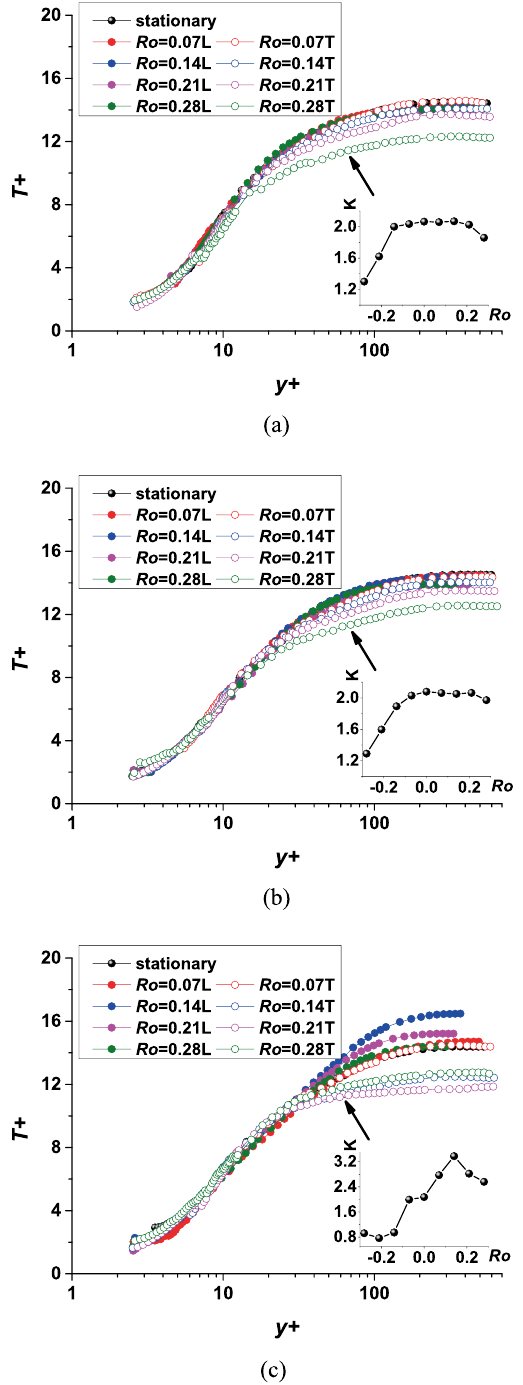
Figure 8. Dimensionless temperature profiles under different Ro and x/D . ( a ) location 0; ( b ) location 1; ( c ) location 2 (“L” represents for leading side and “T” represents for trailing